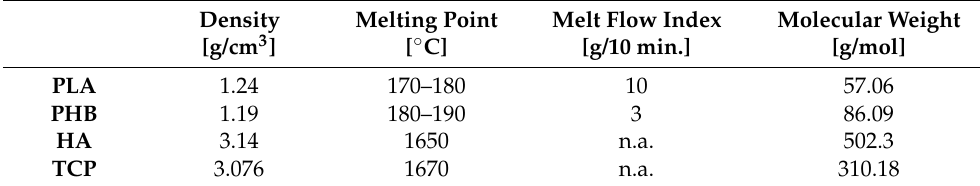
Table 1. Thermo-Physical Properties of Materials.